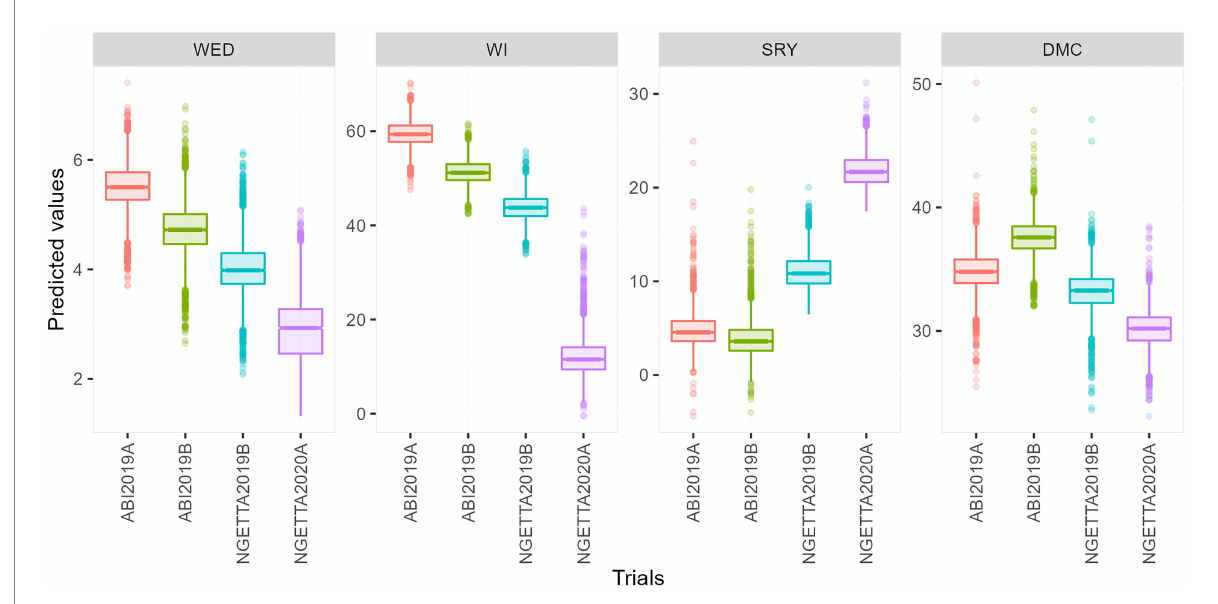
FIGURE 1 Boxplots of predicted means for weevil severity, weevil incidence, storage root yield, and dry matter content across four environments.